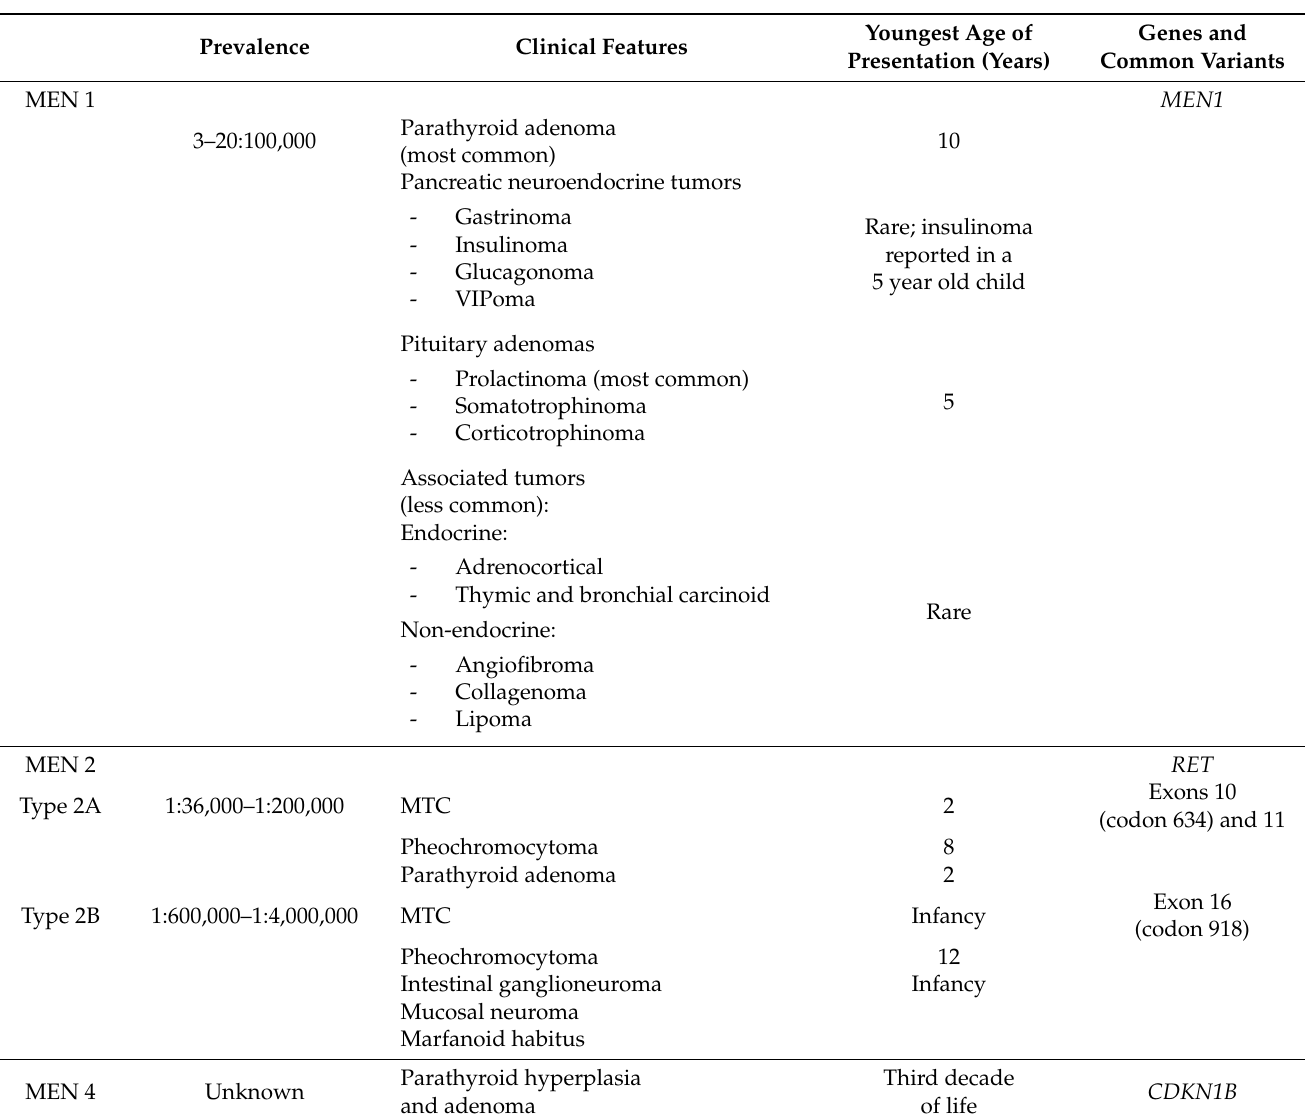
Table 1. MEN syndrome types and associated clinical and genetic characteristics in